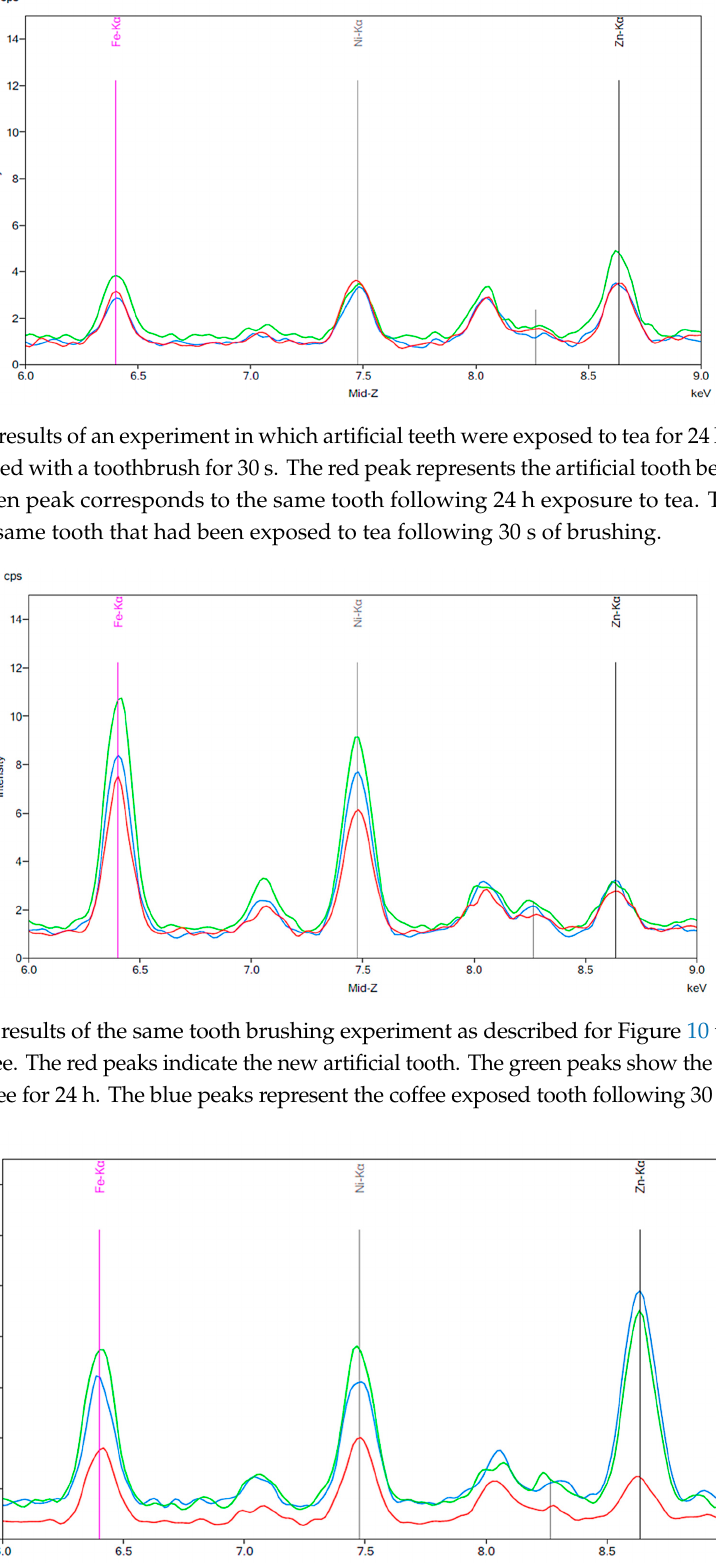
Figure 12. The results of the tooth brushing experiment for artificial teeth exposed to cola. The red peaks indicate new artificial teeth. The green peaks represent the artificial teeth after 24 h exposure to cola. The blue peaks correspond to the cola exposed tooth following 30 s of brushing.